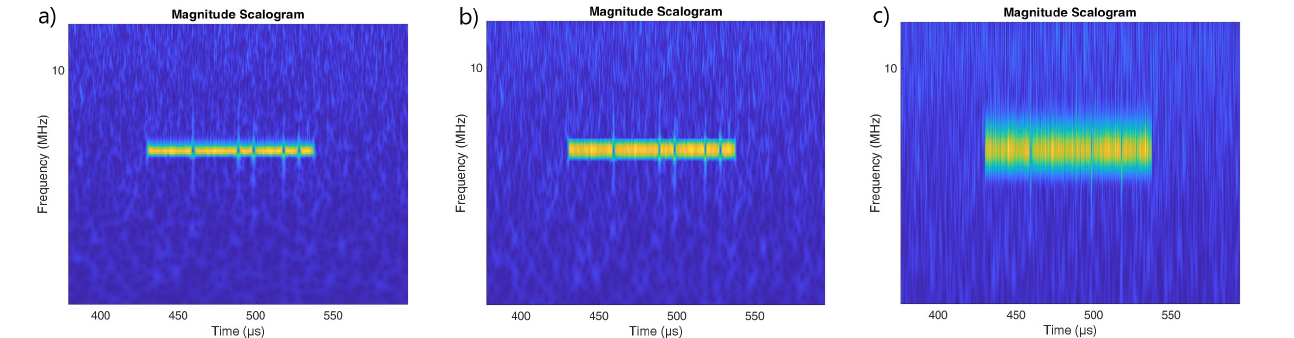
Figure 5. Scalogram for the one pulse phase coded (PC) with Barker code signal made using wavelets: ( a ) Morse γ = 27, β = 27. ( b ) Bump ( c ) Morse (default parameters) γ = 3, β = 20. For SFM waveforms the Morse wavelet with γ = 27, β = 27 is recommended for best frequency resolution (Figure 5).